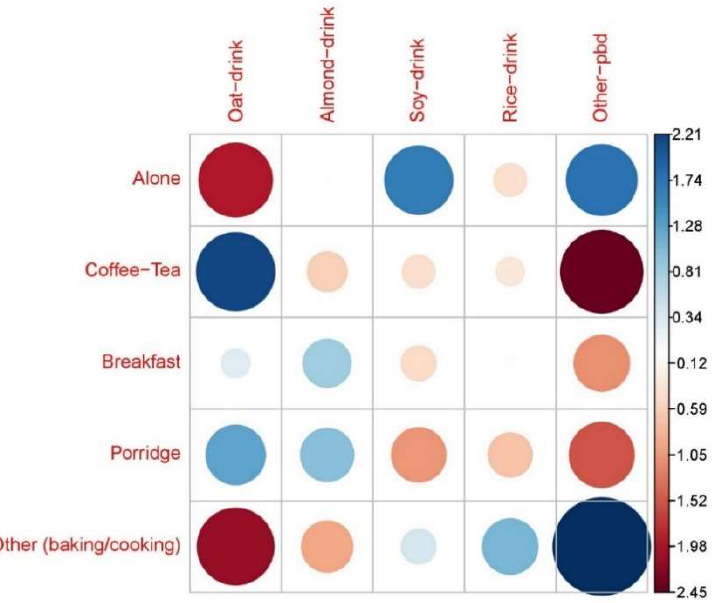
Figure 1. Pearson residuals extracted from the output of the Chi-square Independence test between ‘PBD type’ and ‘Usage type’. Blue: positive association, red: negative association. Pearson residual (>0) positive association and (<0) negative association. Table 3. Perceptions of consumers and non-consumers towards PBMA 1 .